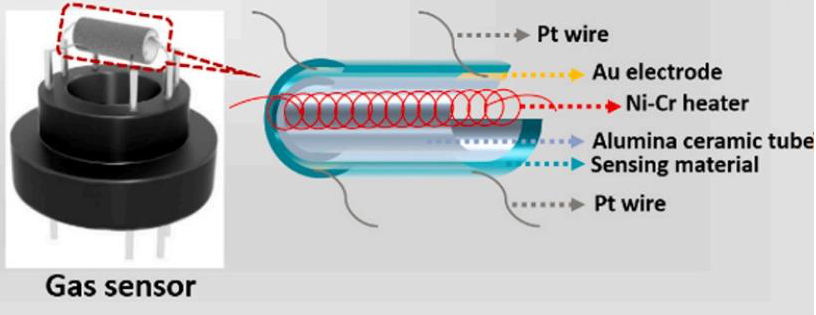
Figure 21. Schematic diagram of sintered indirectly heated gas sensor structure [61].